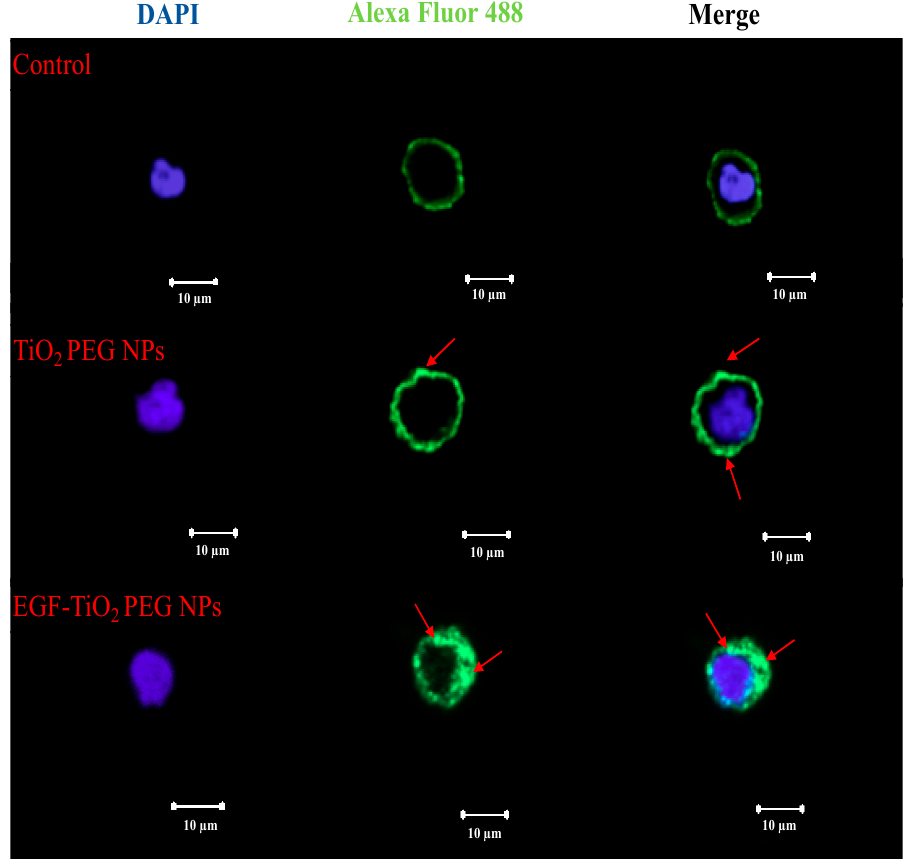
Figure 5. Effect of non-conjugated and EGF-conjugated TiO 2 PEG NPs on epidermal growth factor receptor (EGFR) localization in A431 cells. A431 cells were incubated without (upper panel) or with 10 µ g / mL of TiO 2 PEG NPs (middle panel) and EGF-TiO 2 PEG NPs (lower panel) for 24 h followed by immunofluorescence staining with anti-EGFR antibody (green). The nuclei were stained with 4 (cid:48) ,6-diamidino-2-phenylindole (DAPI) (blue), and fluorescence images were taken with a confocal microscope. Scale bar = 10 µ